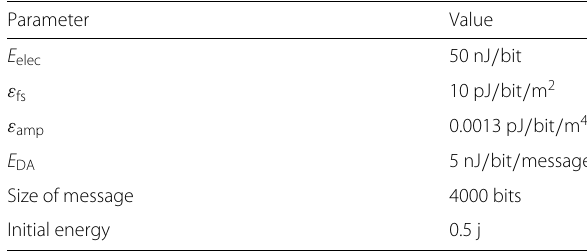
Table 2 Configuration parameters